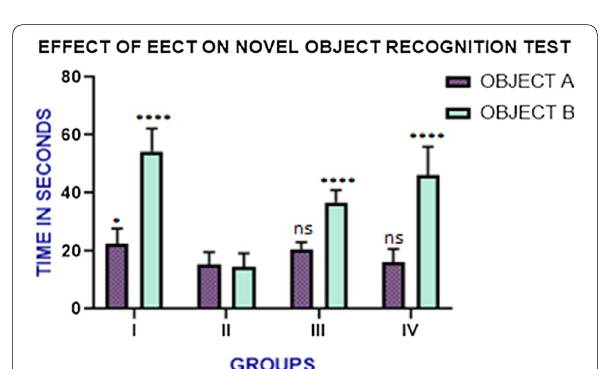
Fig. 3 Effect of EECT on novel object recognition